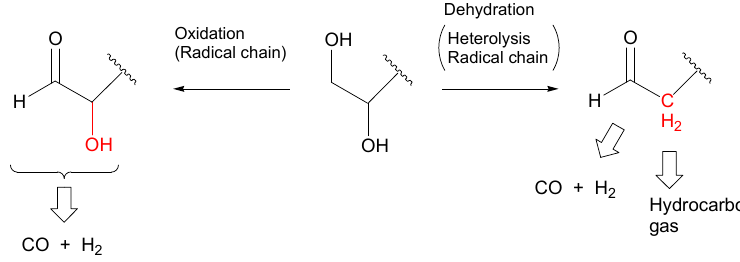
Figure 16. Syngas and hydrocarbon gas formation pathways from polyalcohol.